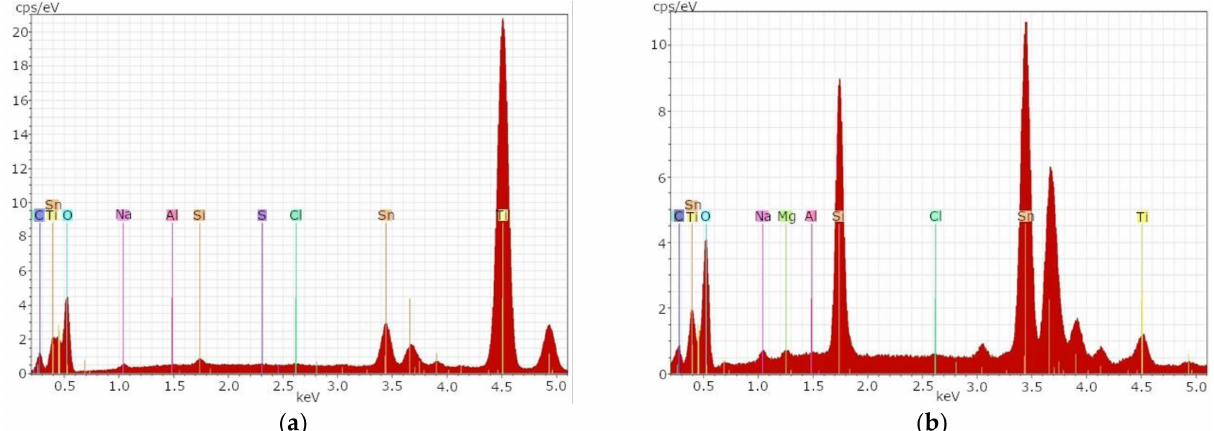
Figure 1. SEM-EDX result for sample t1A, the TiO 2 -coated front electrode of a DSSC: ( a ) before etching; ( b ) after etching.